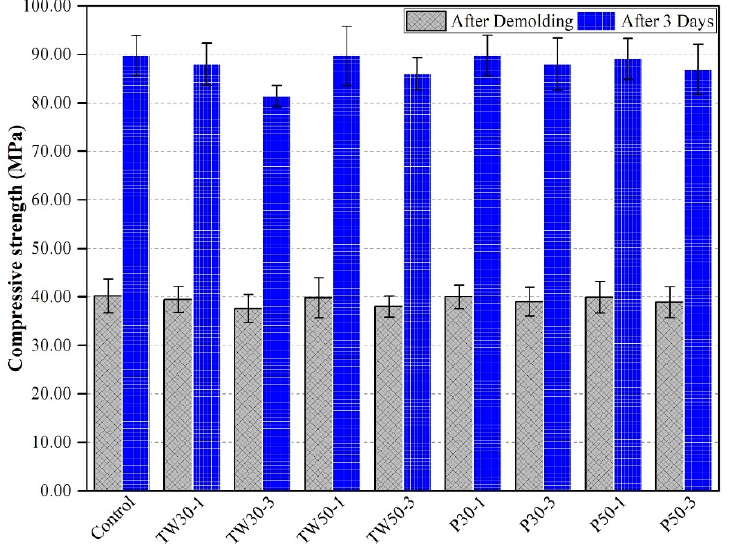
Figure 8. Compressive strength of specimens.